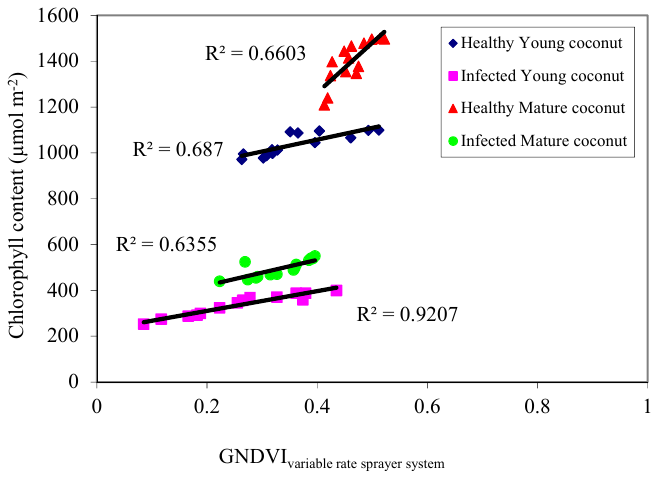
Figure 8. Estimation of leaf chlorophyll content using the green normalized differential vegetation index (GNDVI) and variable rate sprayer system for healthy and infected coconut trees.